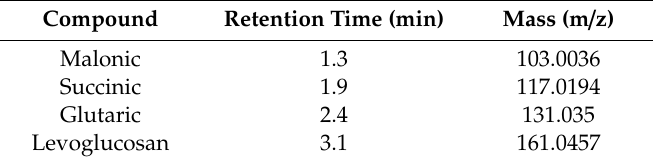
Table 3. Selected parameters for the identification of dicarboxylic acids and levoglucosan by UHPLC.